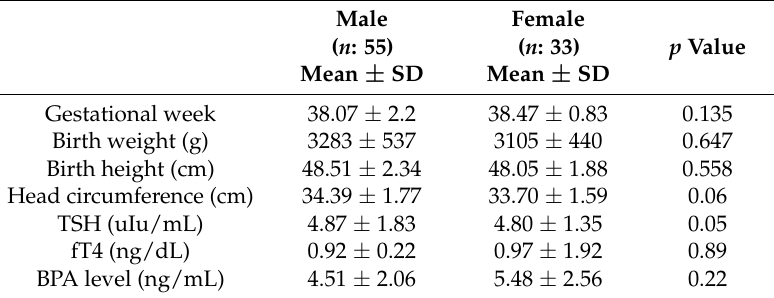
Table 1. Demographic and laboratory characteristics of the study participants.